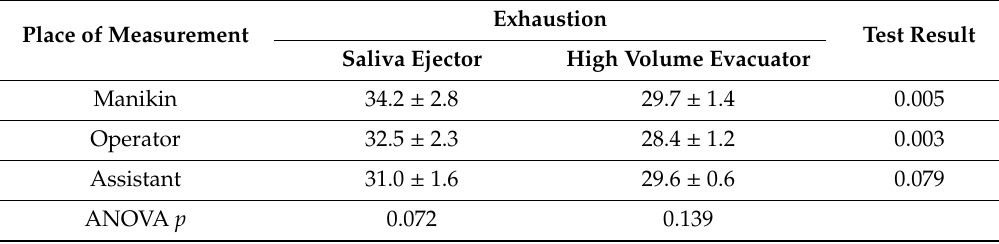
Table 3. The amount of the dental spray during ultrasonic scaling with a high volume evacuator or saliva ejector, measured in 3 areas and the analysis of variance and post-hoc test (multiple comparisons using the Tukey